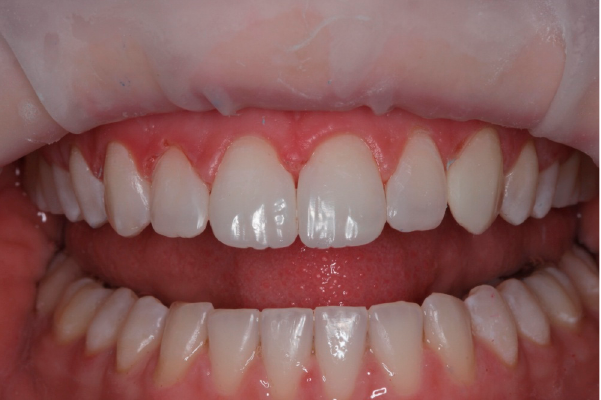
Figure 7. Case 2 post-operative photograph showing surface details with macro- and micro-anatomy.